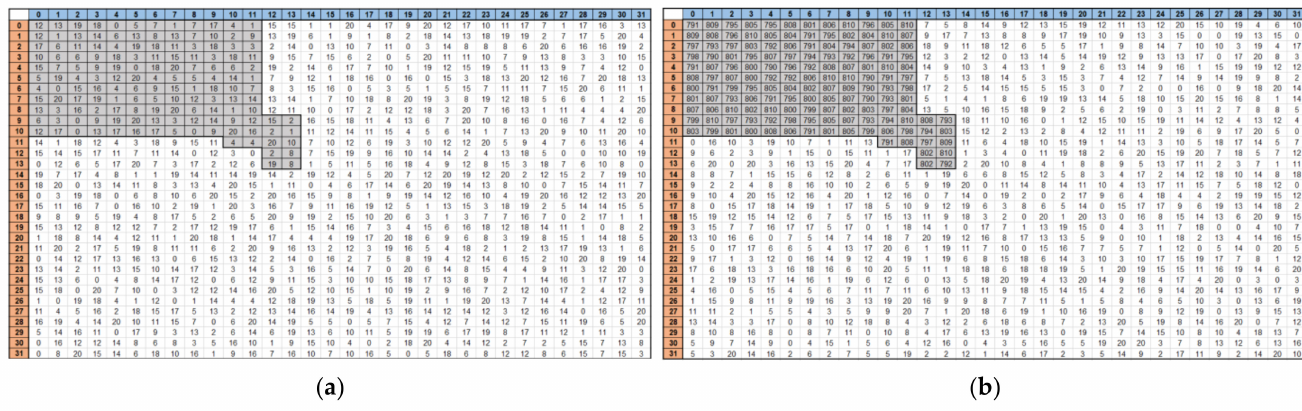
Figure 3. Comparison of biosensor modeling ( a ) without and ( b ) with